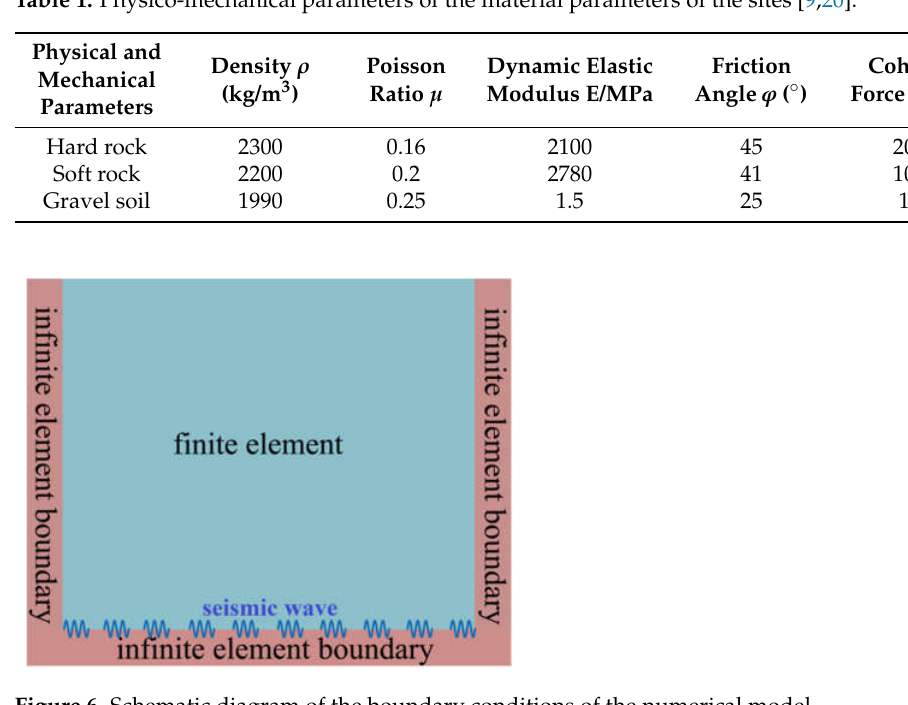
Figure 5. Mesh model used in the calculations: ( a ) homogeneous rock mass site (Model 1), ( b ) hori- zontally layered site (Model 2) and ( c ) layered site with strata dip angle of 10° (Model 3). Table 1. Physico-mechanical parameters of the material parameters of the sites [9,20].